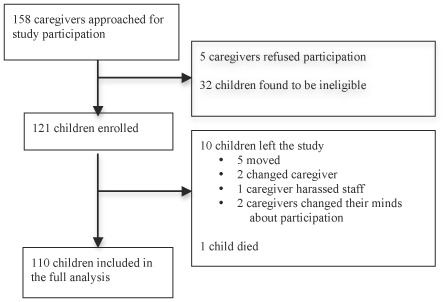
Study participants.